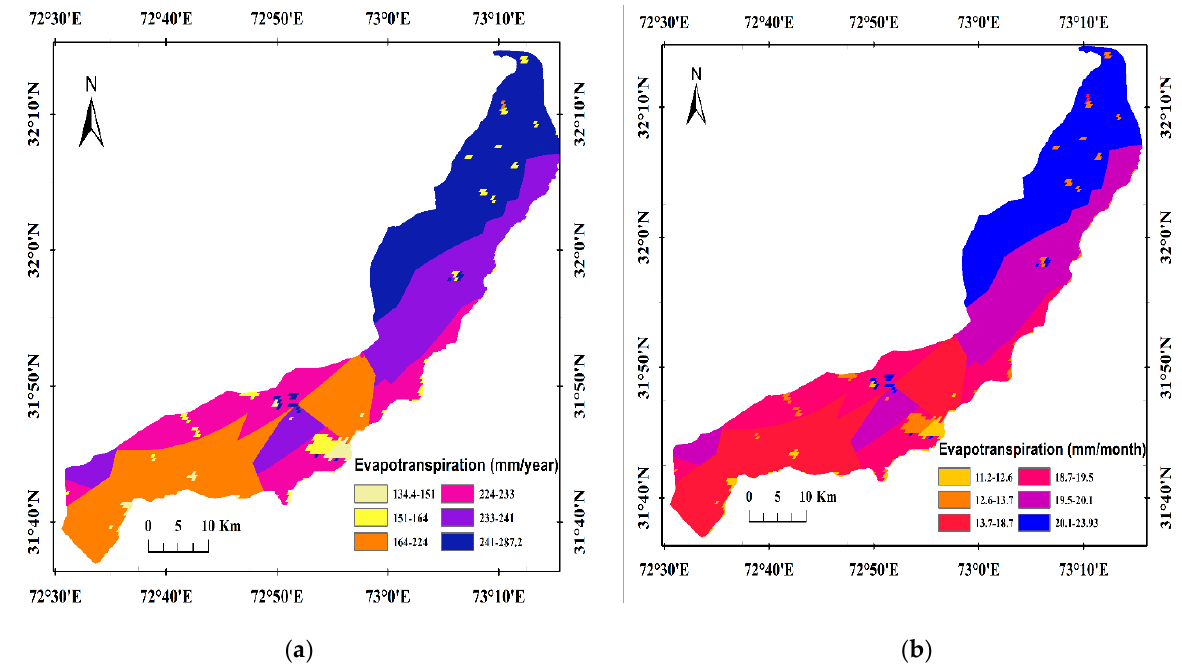
Figure 9. Long-term simulated evapotranspiration ( a ) annual and ( b ) monthly.